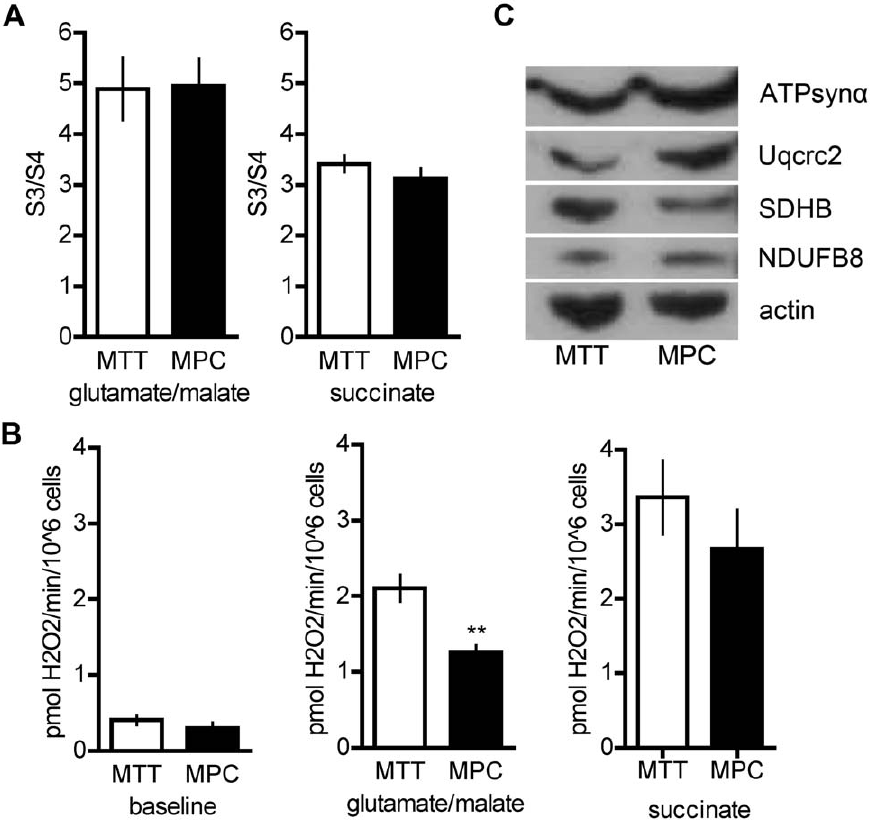
Figure 2. Oxidative phosphorylation complex activity, reactive oxygen species production, and expression of selected oxidative phosphorylation complex subunits in MPC and MTT. A Ratio of ADP-stimulated (S3) and baseline oxygen consumption (S4) in MPC and MTT. B Baseline hydrogen peroxide levels (left) and those observed after addition of substrate (glutamate/malate, complex I (center); succinate, complex II (right). ** indicates p , 0.01. C protein expression of selected subunits of OXPHOS complexes (complex I: NADH dehydrogenase 1 beta subcomplex subunit 8 (NDUFB8); complex II: succinate dehydrogenase B (SDHB); complex III: ubiquinol-cytochrome-c reductase complex core protein 2 (Uqcrc2); complex V: ATP synthase a (ATPsyn a )).